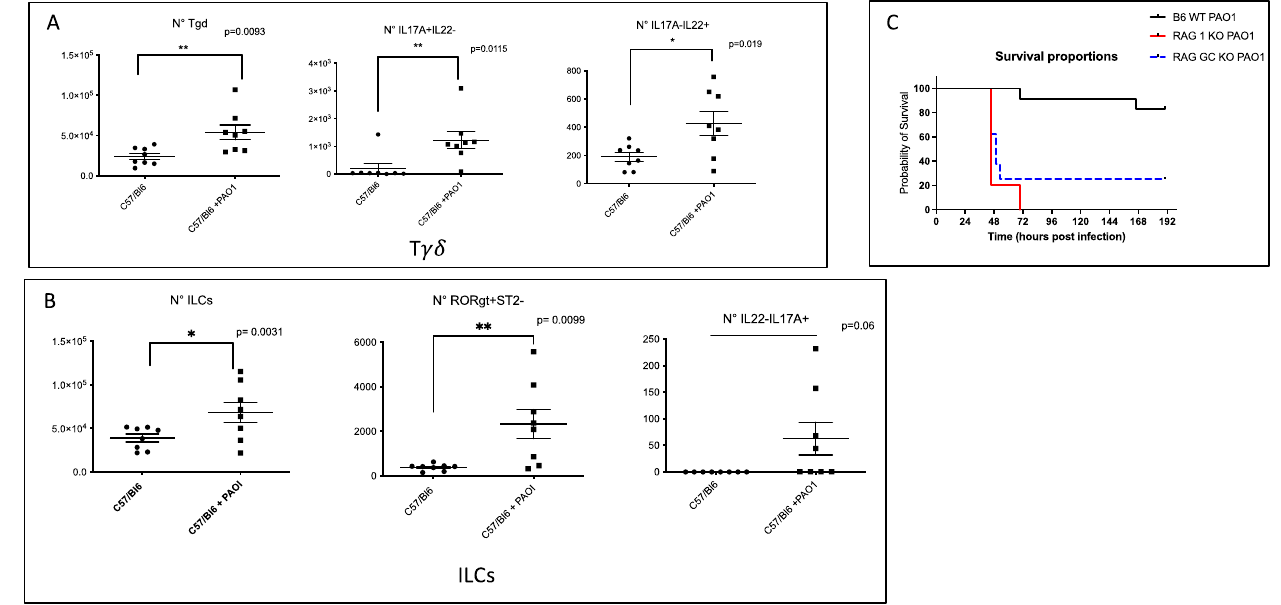
Figure 1. P. aeruginosa (PAO1) infection increases the levels of IL-17+ and IL 22+ T γδ and ILCs. Male C57/Bl6 mice were infected for 16 h with P. aeruginosa (PAO1 strain, 10 7 cfu = colony forming units). Animals were then culled, lungs isolated and treated for FACS analysis (see Materials and Methods, Figure S1 and Supplementary Table S1 for the list of antibodies used). Panel ( A ): shown are the number of total T γδ cells, IL-17+ T γδ , and IL-22+ T γδ cells (see Figure S1 for the FACS gating strategy); Panel ( B ): shown are the number of total ILCs, ‘ILC3 ILCs’ (ROR γ t+), and IL-17 + ILCs (see Figure S1 for the FACS gating strategy). Each symbol represents an individual mouse. Unpaired t-tests have been performed to assess statistical significance (* p < 0.05, ** p < 0.01); Panel intra-nasally with 5.10 7 cfu and survival curves were plotted using Kaplan–Meier curves.